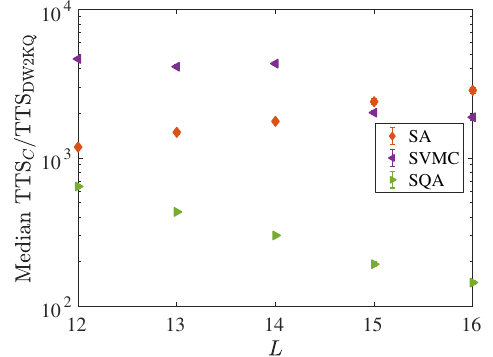
FIG. 13. Median quantile of ratios for the logical-planted instances. We show the ratio of the different classical solvers C ¼ f SA ; SQA ; SVMC g to the DW2KQ. A positive slope, as for SA and SVMC algorithms, indicates a scaling advantage for the DW2KQ, while a negative slope, as for SQA, indicates a slowdown. The data symbols obscure the error bars representing the 95% confidence intervals ( 2 σ ) calculated using 1000 boot- straps of 1000